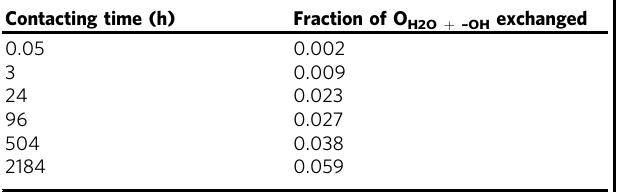
Table 2 Fraction of exchanged mobile O Contacting time (h) Fraction of O H2O + – OH exchanged